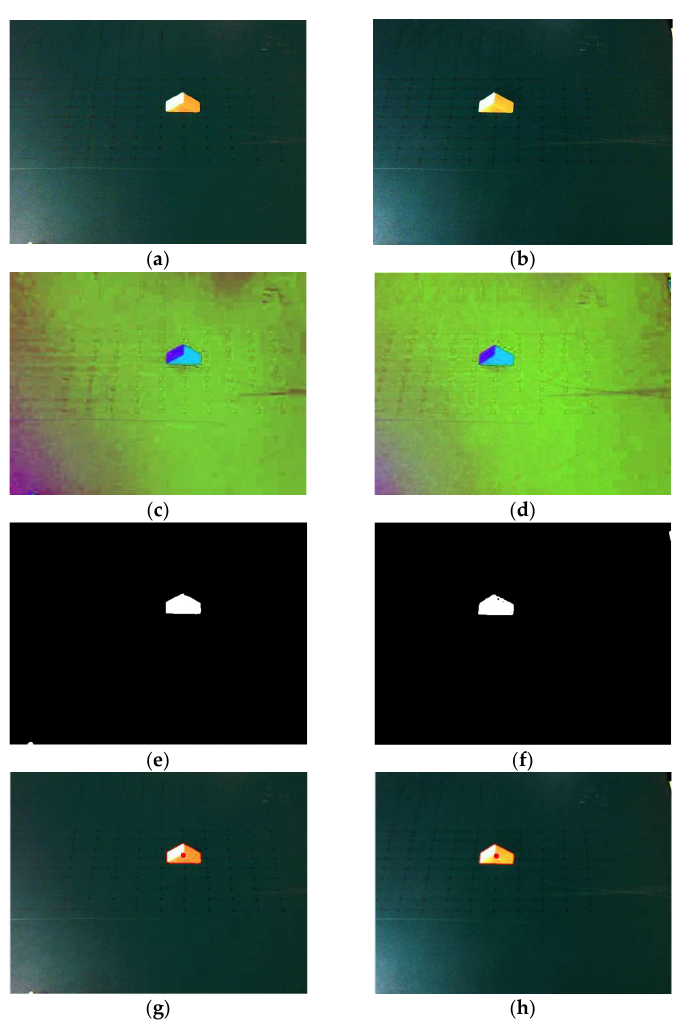
Figure 11. Target feature extraction and pose estimation process: ( a ) Color image taken by the left camera, ( b ) Color image taken by the right camera, ( c ) Image of the left camera on the HSV space, ( d ) Image of the right camera on the HSV space, ( e ) Filtered image of the left camera, ( f ) Filtered image of the right camera, ( g ) Object pose estimation on the left camera, and ( h ) Object pose estimation on the right